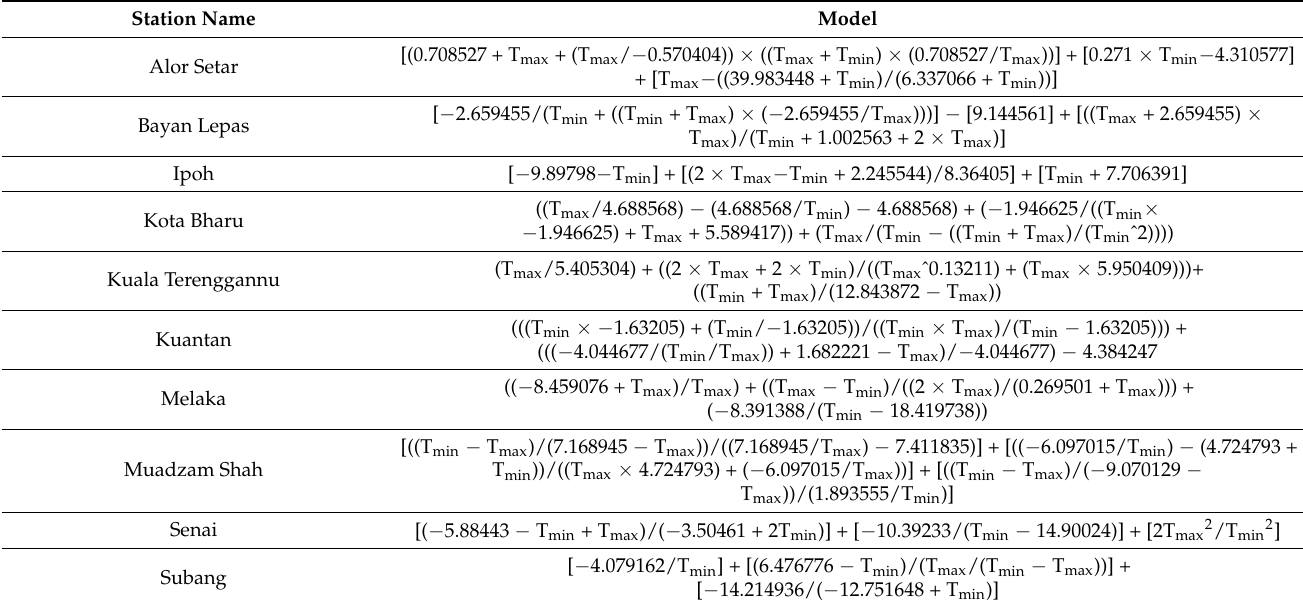
Table 3. The GEP models developed at all the stations in Peninsular